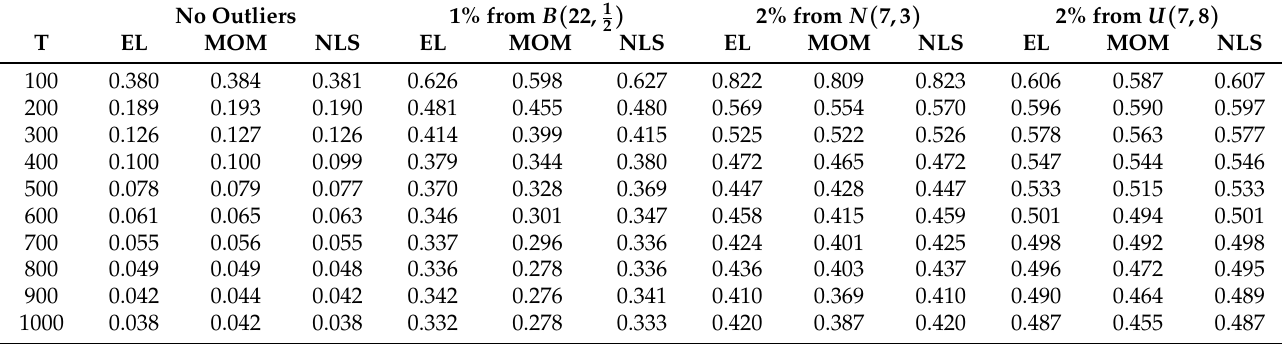
Table 2. MSE for (cid:98) θ NLS , (cid:98) θ MOM , (cid:98) θ EL in Example 2.